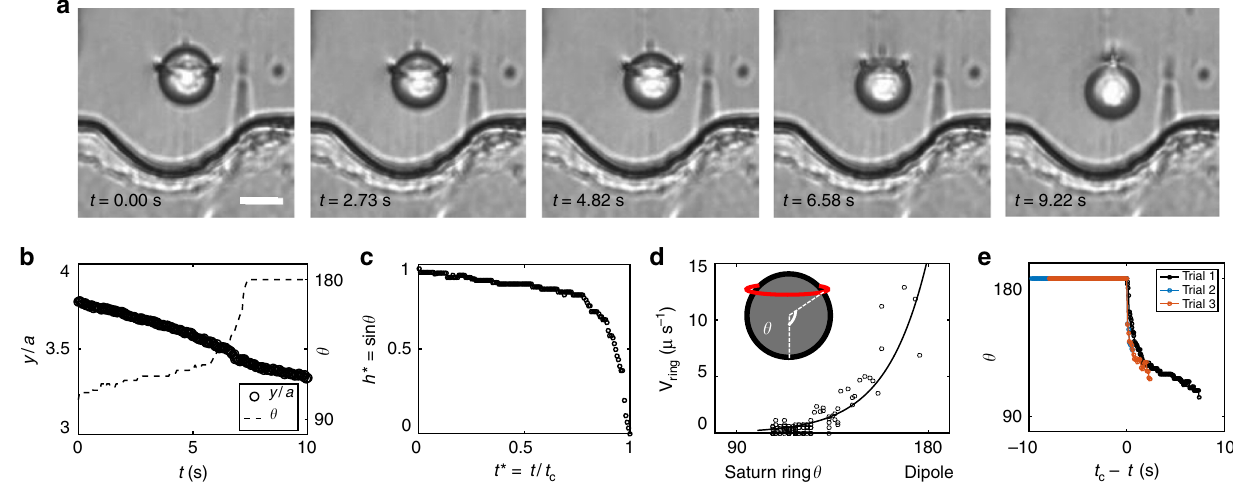
Fig. 4 Dynamics of the quadrupole to dipole transition. a Time-lapse image of a Saturn ring transforming to a dipole at a metastable position remotely from the wall de fi ned by the elastic energy fi eld (see Supplementary Movie 1). The scale bar is 10 μ m. b The y location of the colloid ’ s center of mass (COM) and evolution of the polar angle θ during the transition. Initially, the colloids assume the θ = 90° (Saturn ring) con fi guration, which gradually evolves to θ = 180° as the COM continuously moves towards the wall. After the transition to a dipolar con fi guration, the particle approaches the wall. c , d Reduced ring size and velocity from our system reveal similar dynamics of transition as shown in Fig. 2 in Ref. 36 . The solid line serves as guide to the eye. e θ vs. t c − t plot shows three experimental runs of transition in similar geometry. In b – d , t c is the time at which θ =